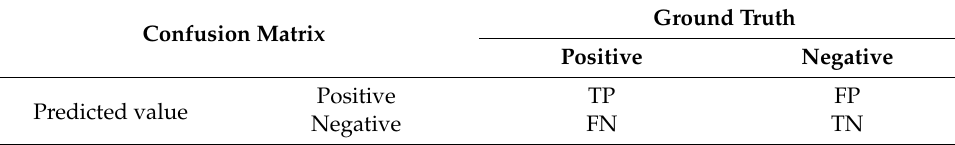
Table 5. Mapping between TP, TN, FP, and FN.